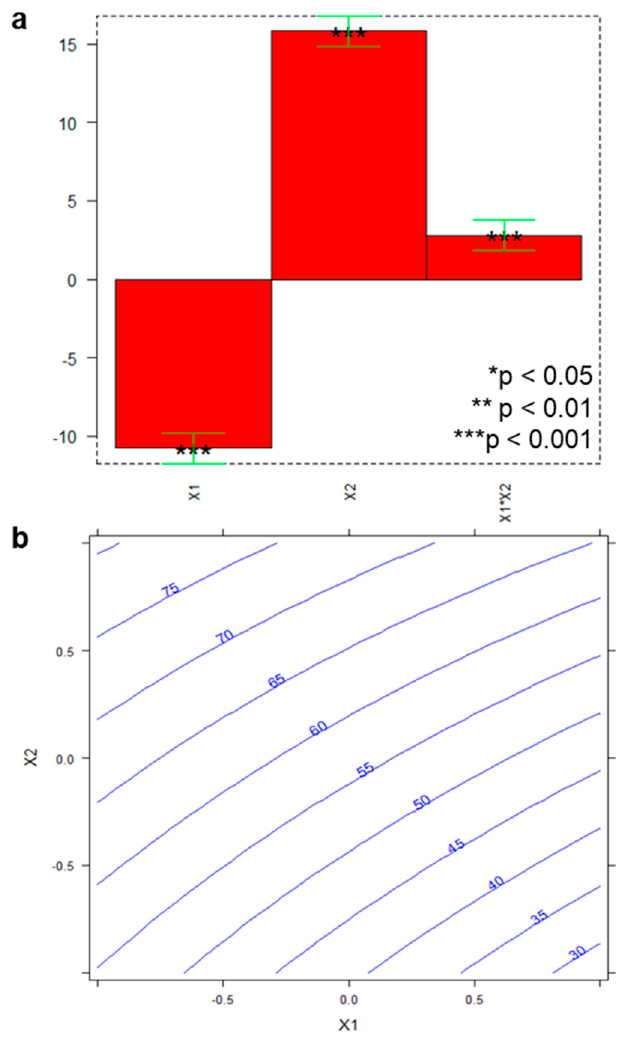
Figure 2. Design of experiments (DoE) results: ( a ) plot of the coefficients of the model (stars indicate the significance level of the coefficients, error bars indicate the confidence interval of the mean values for the coefficients, computed for α = 0.05); ( b ) response surfaces of predicted recovery as function of x 1 (FBS volume) and x 2 (sorbent amount).